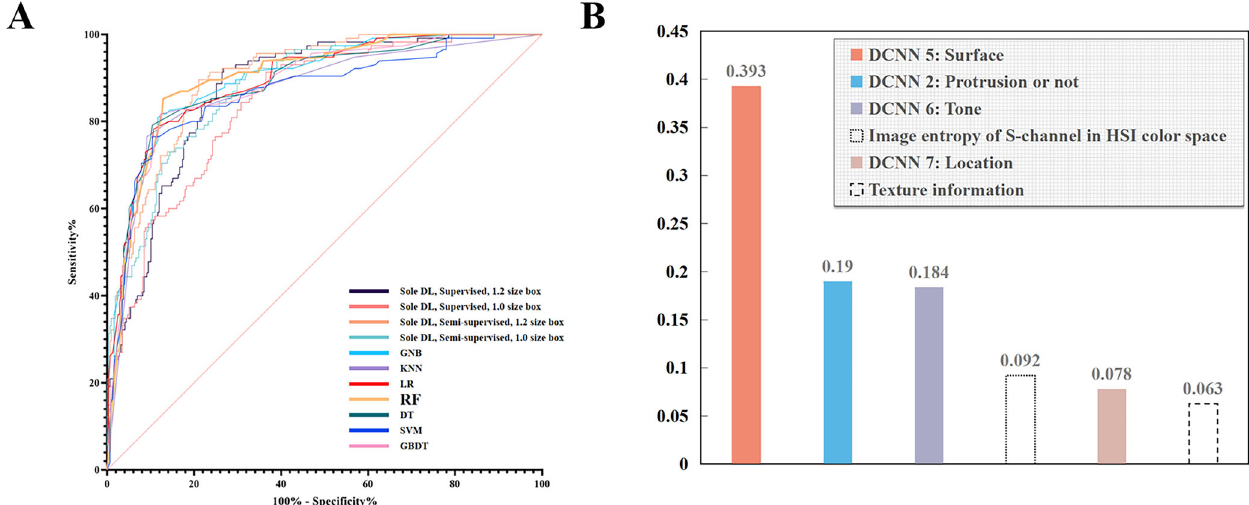
Fig. 3 The schematic diagram of all feature indexes and the framework of developing ENDOANGEL-ED. A Thirteen features, including seven deep learning-based features and six quantitative features. B The framework of developing ENDOANGEL-ED. HIS Hue, Saturation, Intensity.